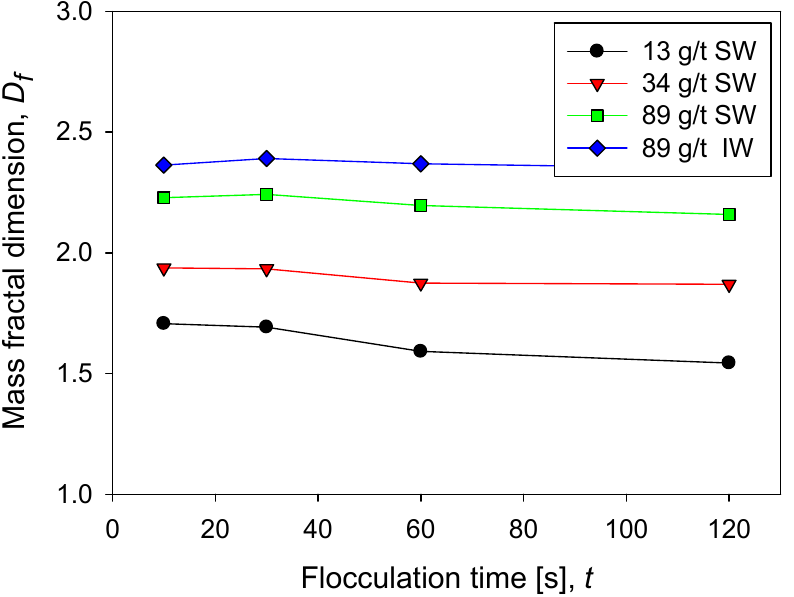
Figure 5. Fractal dimension of kaolin suspensions with different doses of flocculant in SW and IW at a shear rate of 200 rpm.